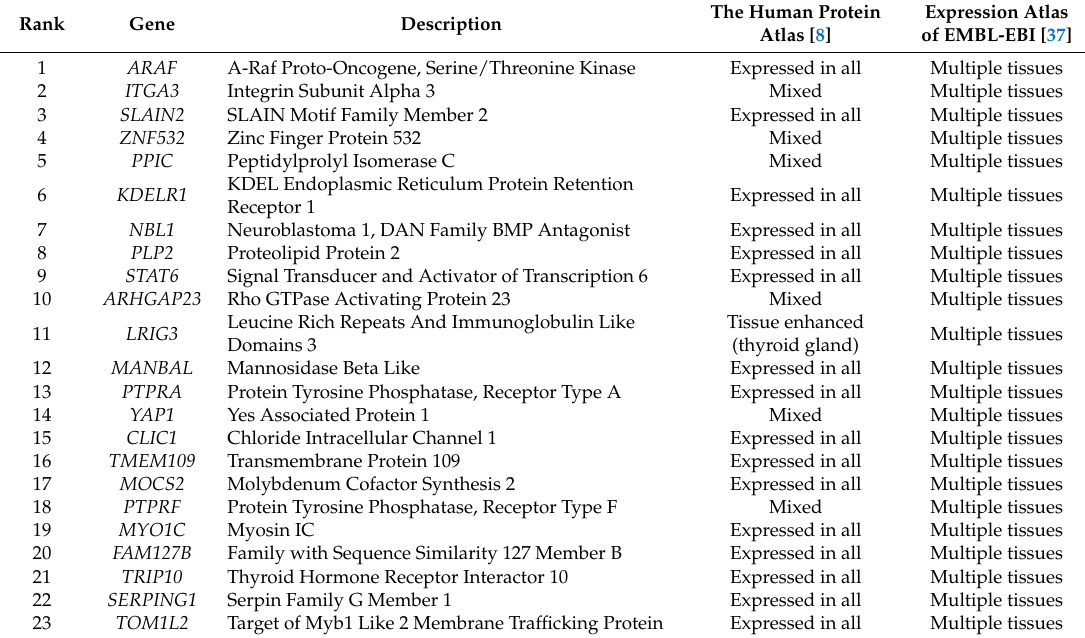
Table 2. The top 23 genes selected for further investigation via a literature review.